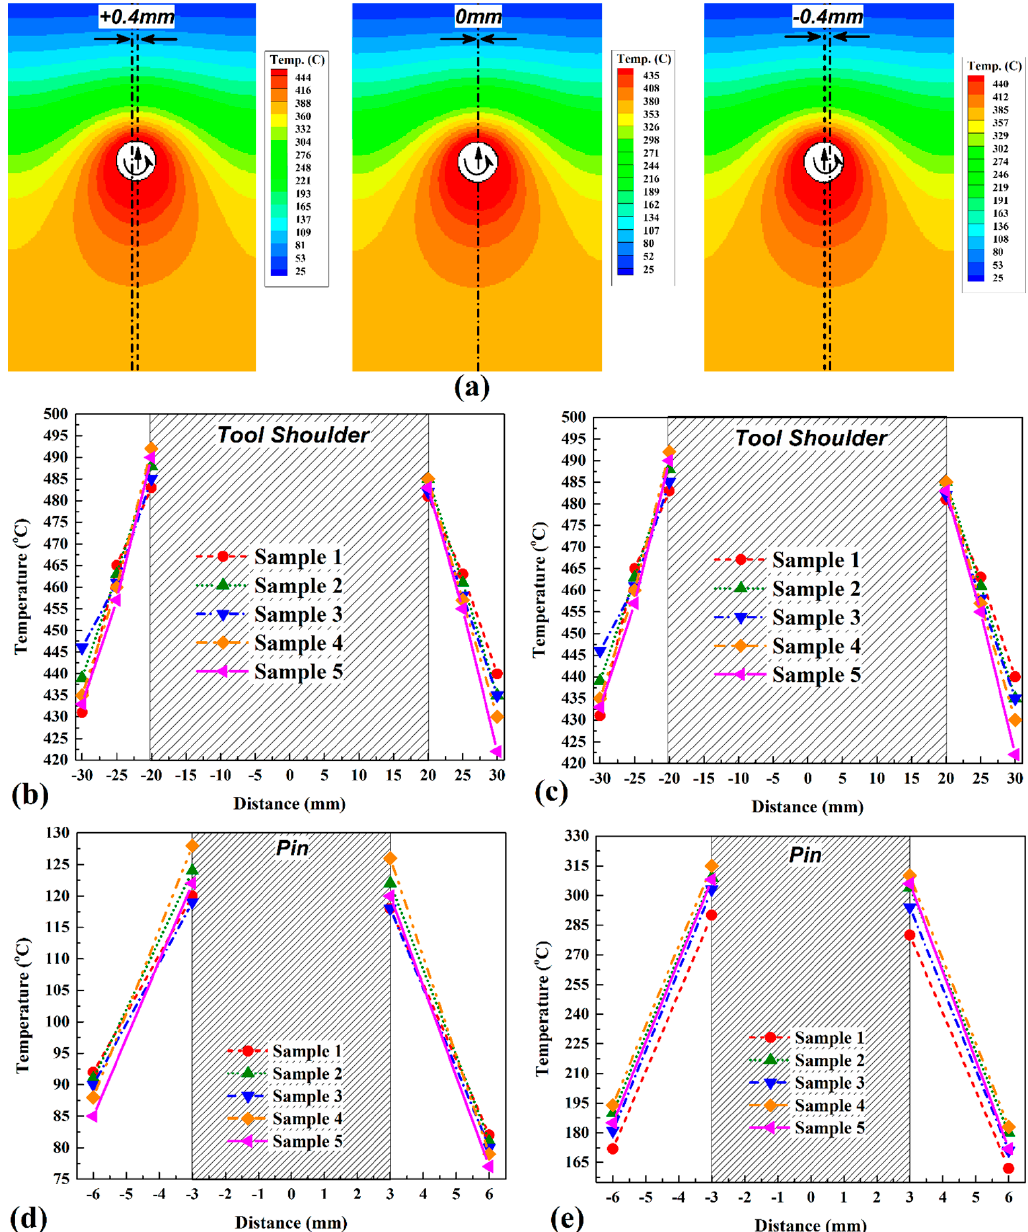
Figure 4. ( a ) Simulation results of surface heat flow at various cases. ( b ) Experimental and ( c ) simulation results of recorded maximum temperature and heat diffusion on skin. ( d ) Experimental and ( e ) simulation results of recorded maximum temperature and heat diffusion on flange.